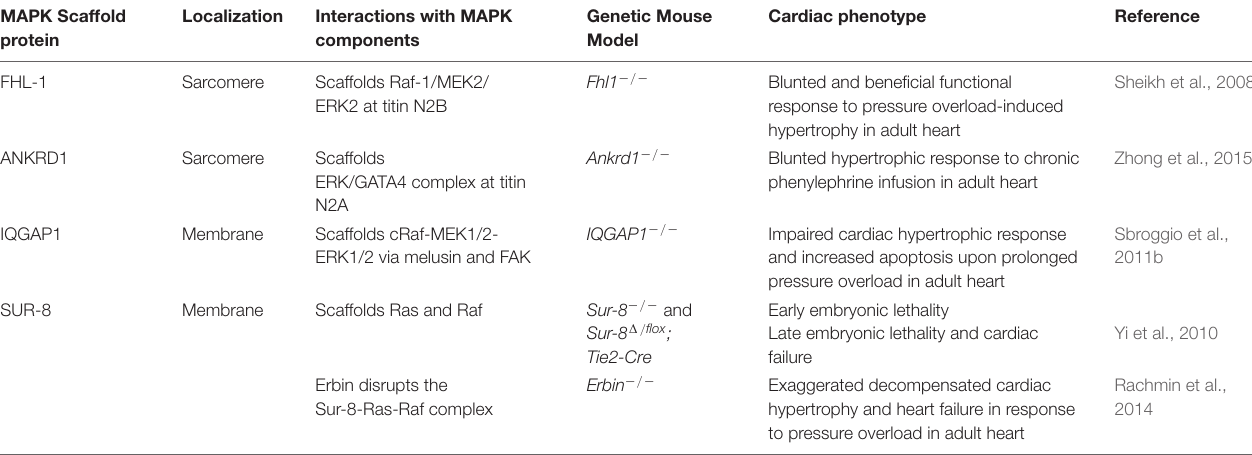
TABLE 1 | Genetic mouse models targeting MAPK scaffold proteins and ERK-mediated signaling in cardiac muscle and their role in cardiac